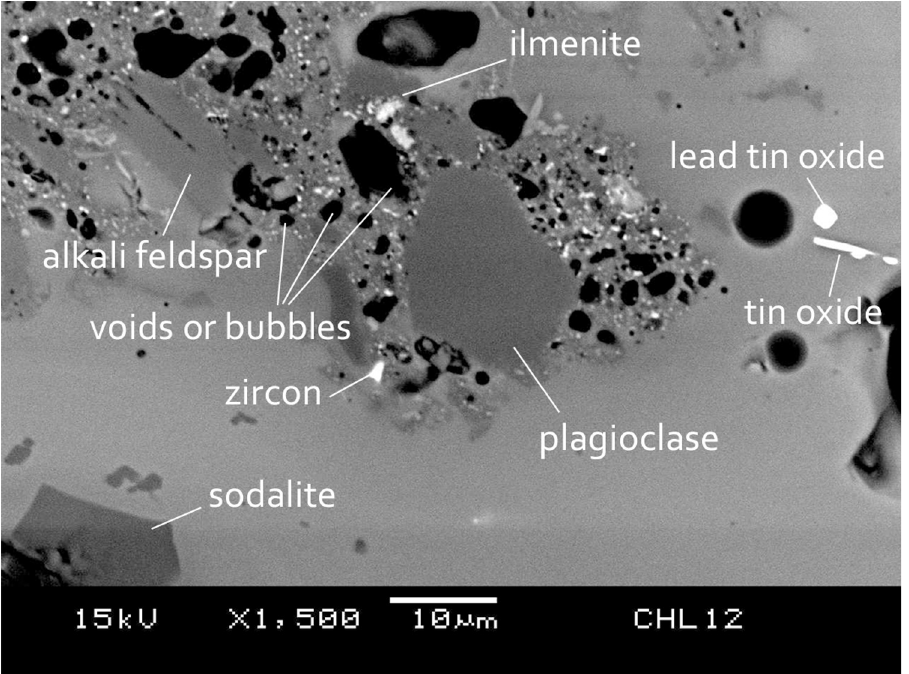
Fig 2. BSE image showing the heterogeneous microstructure of the glass matrix.